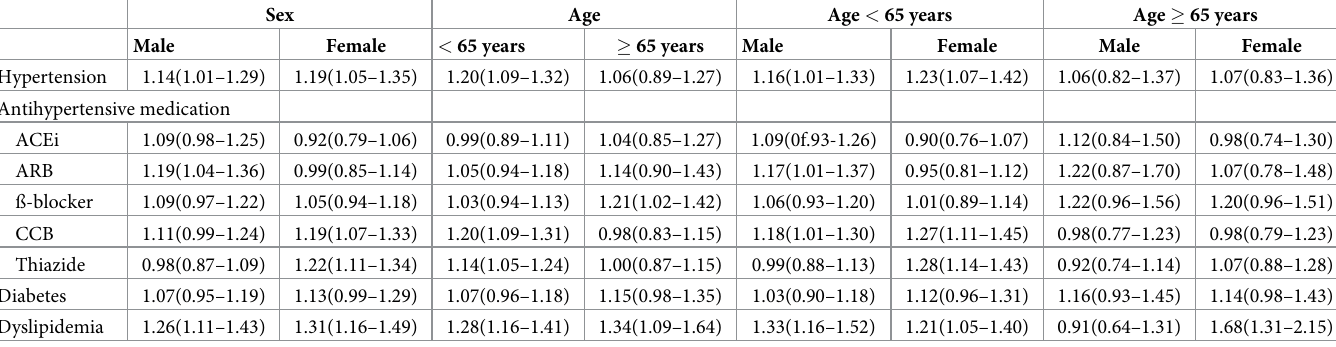
Table 3. Longitudinal association between hypertension and psoriasis incidence according to age and